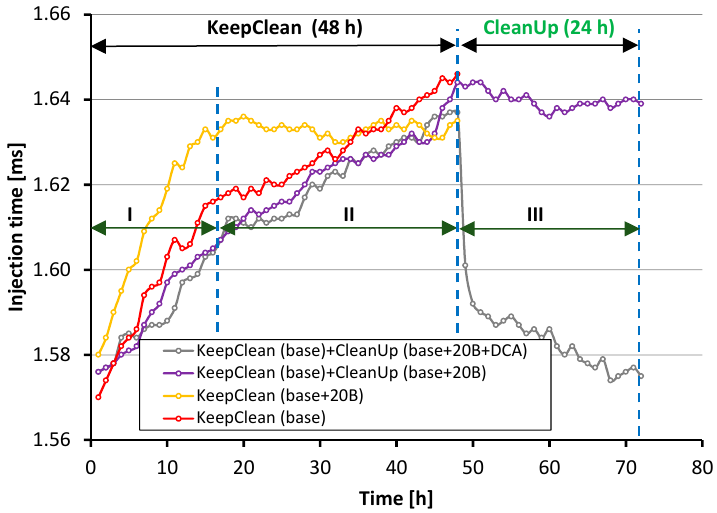
Figure 6. Changes in injection time of single doses of tested fuels obtained in Keep ‐ Clean and Clean ‐ Up tests.